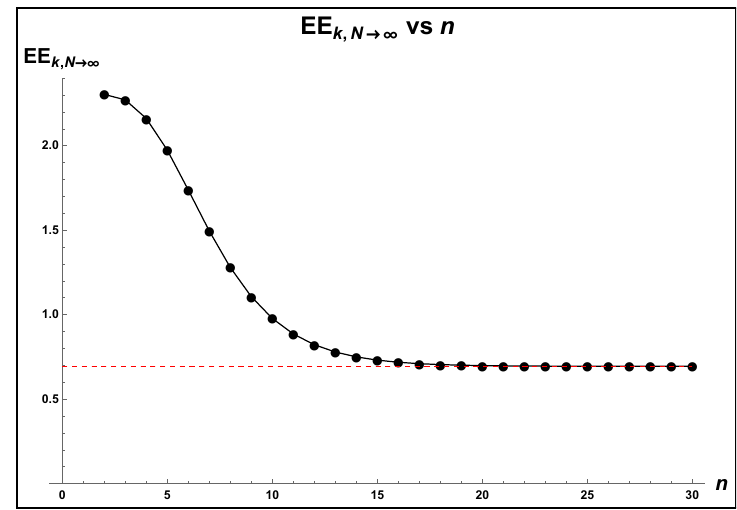
)EE((cid:9) ) as a function of n . The entropy 1 N !1